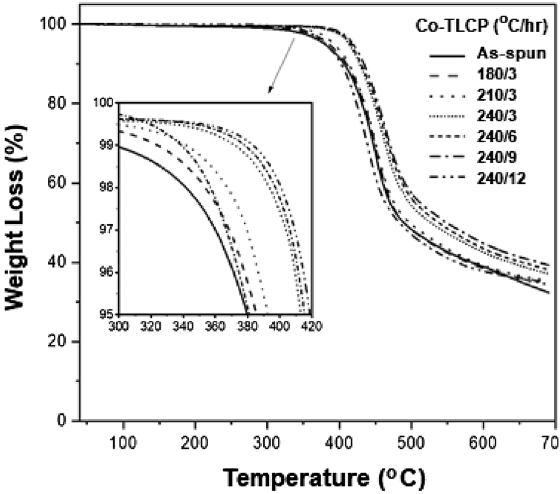
Figure 4. TGA thermograms of the heat-treated Co-TLCP fibers.